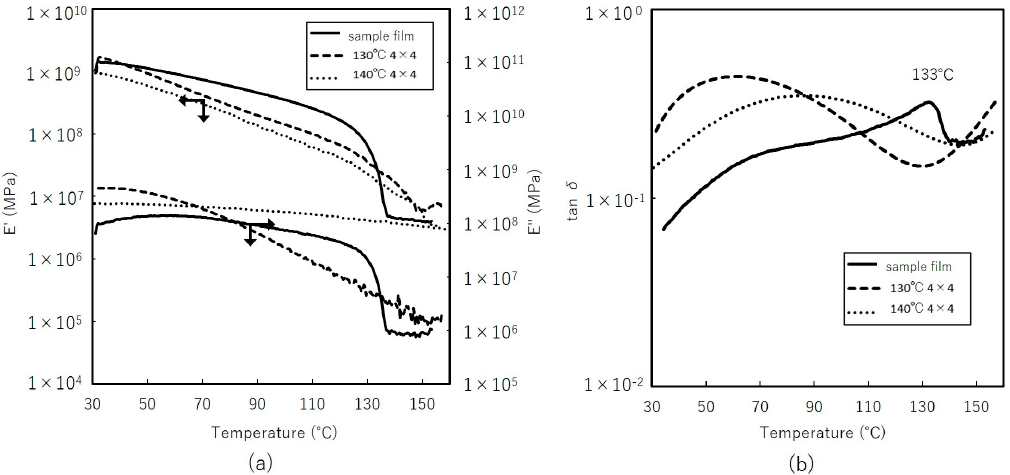
Figure 13. Dynamical mechanical analysis of simultaneous biaxially stretched films. ( a ) Storage and loss modulus ( b ) damping factor tan δ .